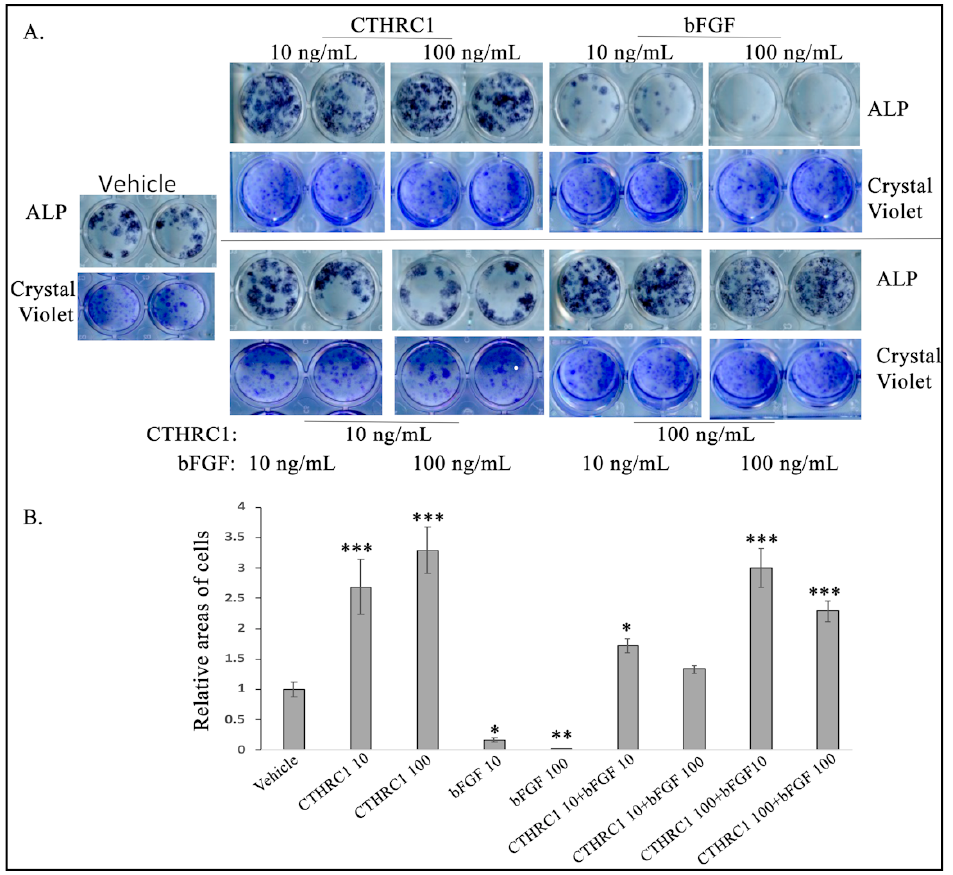
Figure 5. CTHRC1 stimulated, but bFGF inhibited, osteoblastogenesis. ( A ) Representative images of alkaline phosphatase (ALP) or crystal violet staining. ( B ) Relative quantification of the areas of ALP-positive cells normalized by their respective areas of total live cells as indicated by crystal violet staining. Experiments were repeated at least three times with the same results. * p ≤ 0.05, by Student’s t -test. More than 12 mice were used for collecting bone marrows. *** p < 0.001, ** p < 0.01, * p ≤ 0.05, by ANOVA. Other significant differences were found p < 0.001 in CTHRC1 10 vs. bFGF 10, CTHRC1 10 vs. bFGF 100, CTHRC1 10 vs. CTHRC1 10+bFGF 100, CTHRC1 100